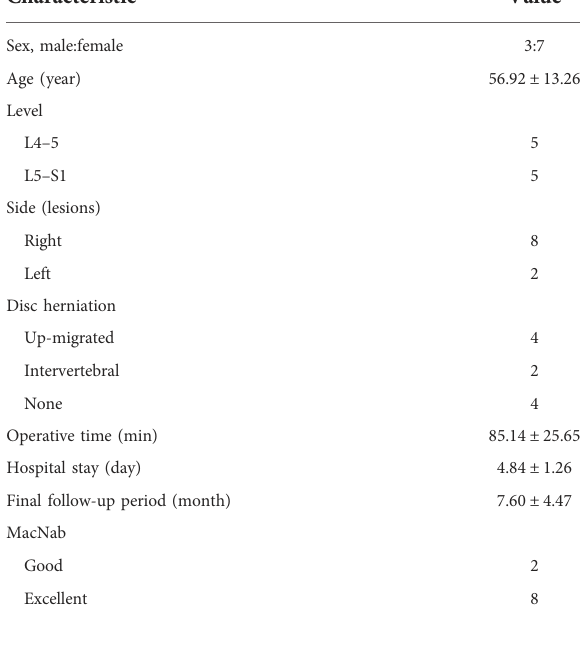
TABLE 1 Patients ’ demographics and disease characteristics ( n